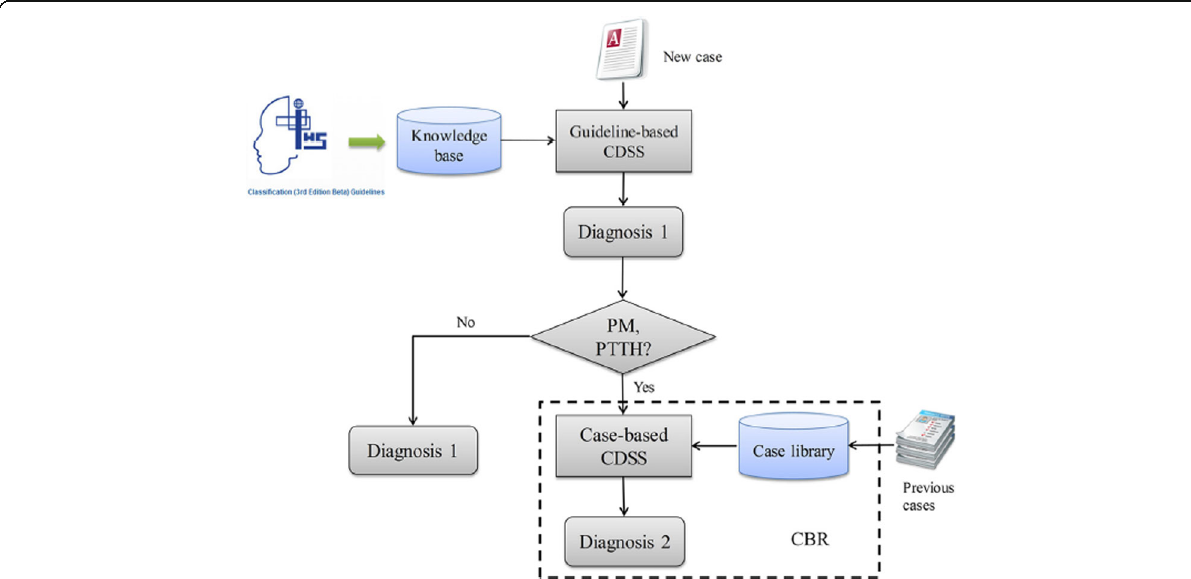
Fig. 1 A computerized clinical decision support system (CDSS) [from reference 13]. CBR, case-based reasoning; PM, probable migraine; PTTH, probable tension-type